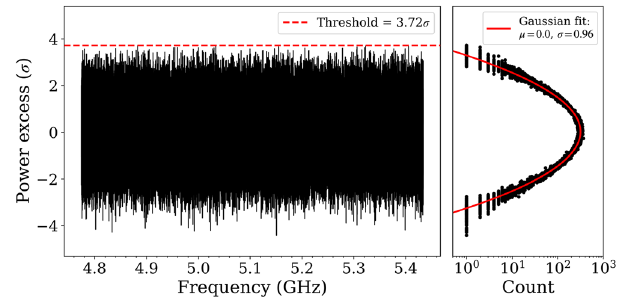
Fig. 4 | Grand spectrum (left) and its projected power excess (right). All the grand spectrum bins are below the selection threshold (red dashed line) after the rescanning procedure which shows all the axion candidates are excluded.